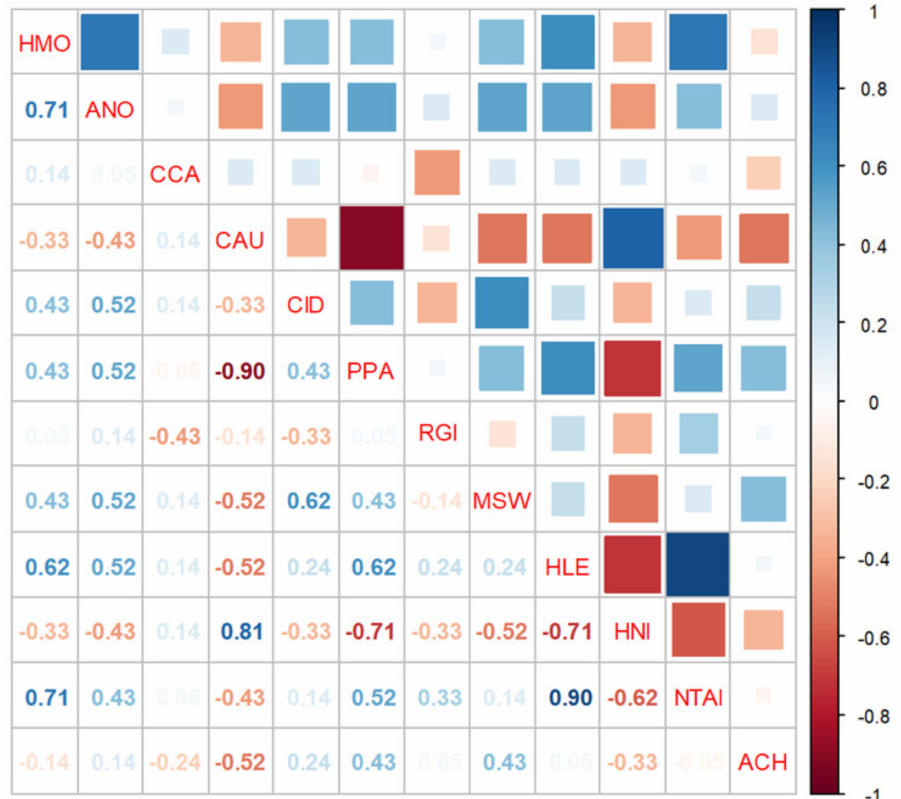
Figure 6. CPUE correlations among dominant fish species and Japanese smelt in Lake Erhai. HMO (Silver carp): Hypophthalmichthys molitrix , ANO (Bighead carp): Aristichthys nobilis , CCA (common carp): Cyprinus carpio , CAU (crucian carp): Carassius auratus , CID (grass carp): Ctenopharyngodon idellus , PPA (topmouth gudgeon): Pseudorasbora parva , RGI (Barcheek goby): Rhinogobius giurinus , MSW (Swinhon’s sleeper): Micropercops swinhonis , HLE (sharpbelly): Hemiculter leucisculus , HNI (Japanese smelt): Hypomesus nipponensis , NTAI (Icefish): Neosalanx taihuensis , ACH (khanka spiny bitterling): Acheilognathus chankaensis